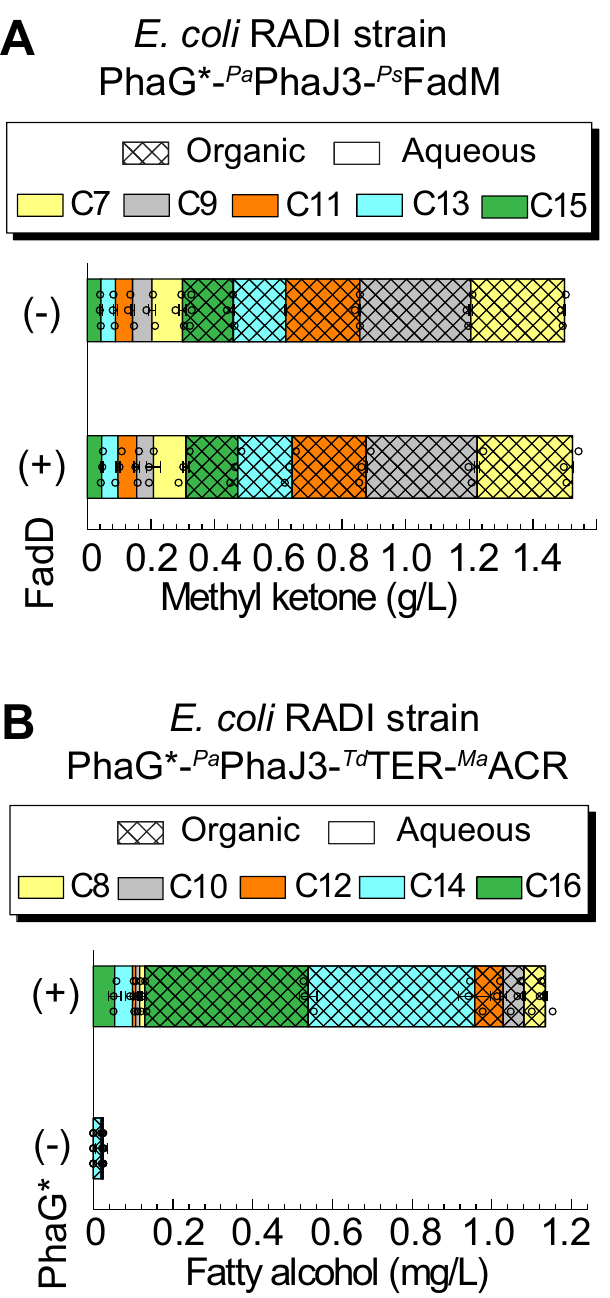
Fig. 5 Methyl ketone and fatty alcohol production using PhaG*. A Methyl ketone production by E. coli RAI or RADI harboring pTRC99a- Pk phaG *- Ps fadM + pACYC- Pa phaJ3 plasmids. B Fatty alcohol production by E. coli RADI harboring pTRC99a- Pk phaG *- Td TER + pACYC- Pa phaJ3 + pBTRCK- Ma ACR . The corresponding negative control harbored a pTRC99a empty vector in place of the PhaG* vector. All cells were grown in 50mL of Clomburg media containing 20g/L glycerol, 20% (v/v) dodecane, and 1mM IPTG at 30°C for 48hrs ( n = 3 biologically independent samples). The shadings and non- shadings in graphs represented products in the dodecane organic layer and aqueous phase, respectively. All data represent the mean ± s.d. of biological triplicates. Source data underlying A, B are provided as a Source Data fi